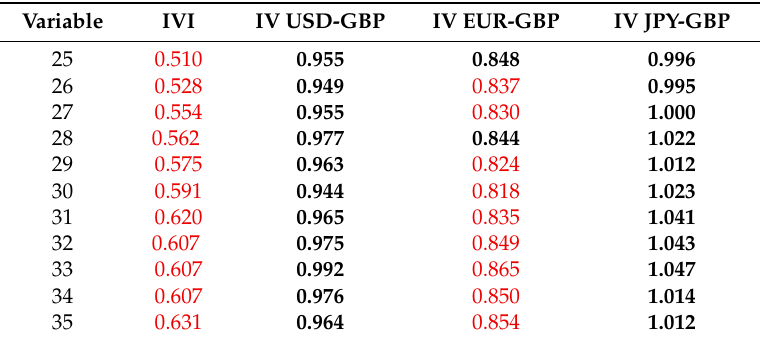
Table 2. Estimates of d for the whole sample using semi-parametric approaches.